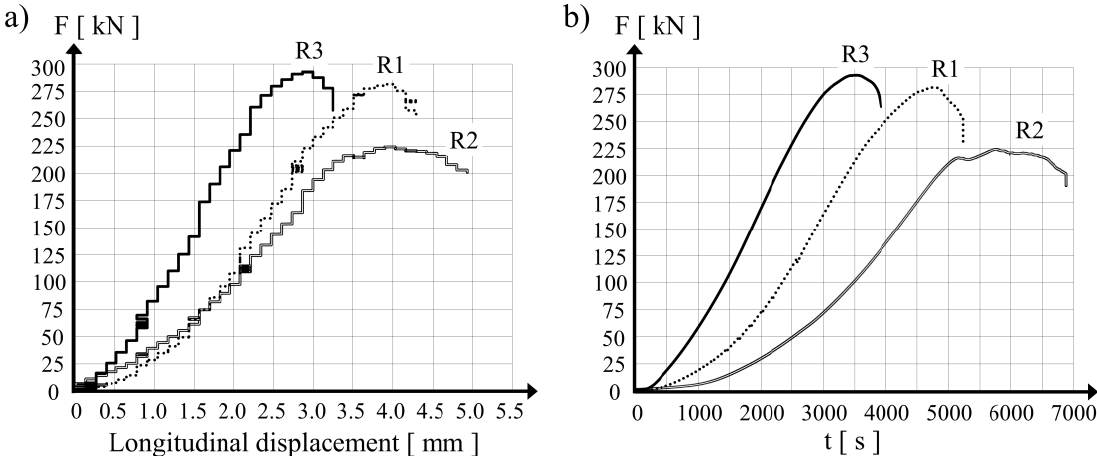
Figure 4. Test results for the three hollow concrete cylinders: ( a ) compression force vs. longitudinal displacement, ( b ) development of the compression force during the test.